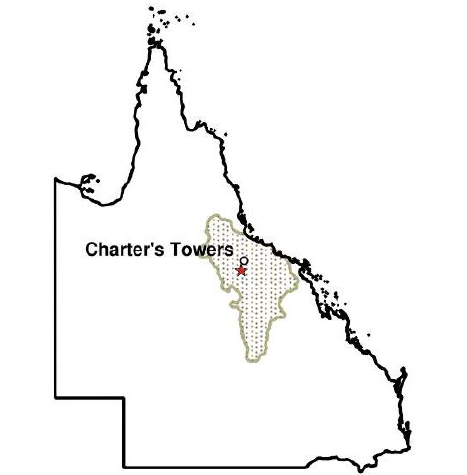
Figure 1. Location of Wambiana grazing trials (red star) within Burdekin Catchment (shaded area), QLD Australia.